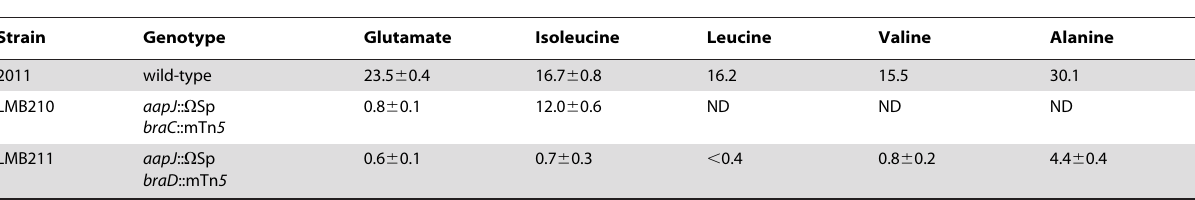
Table 6. Transport of amino acids by strains of Sinorhizobium meliloti.